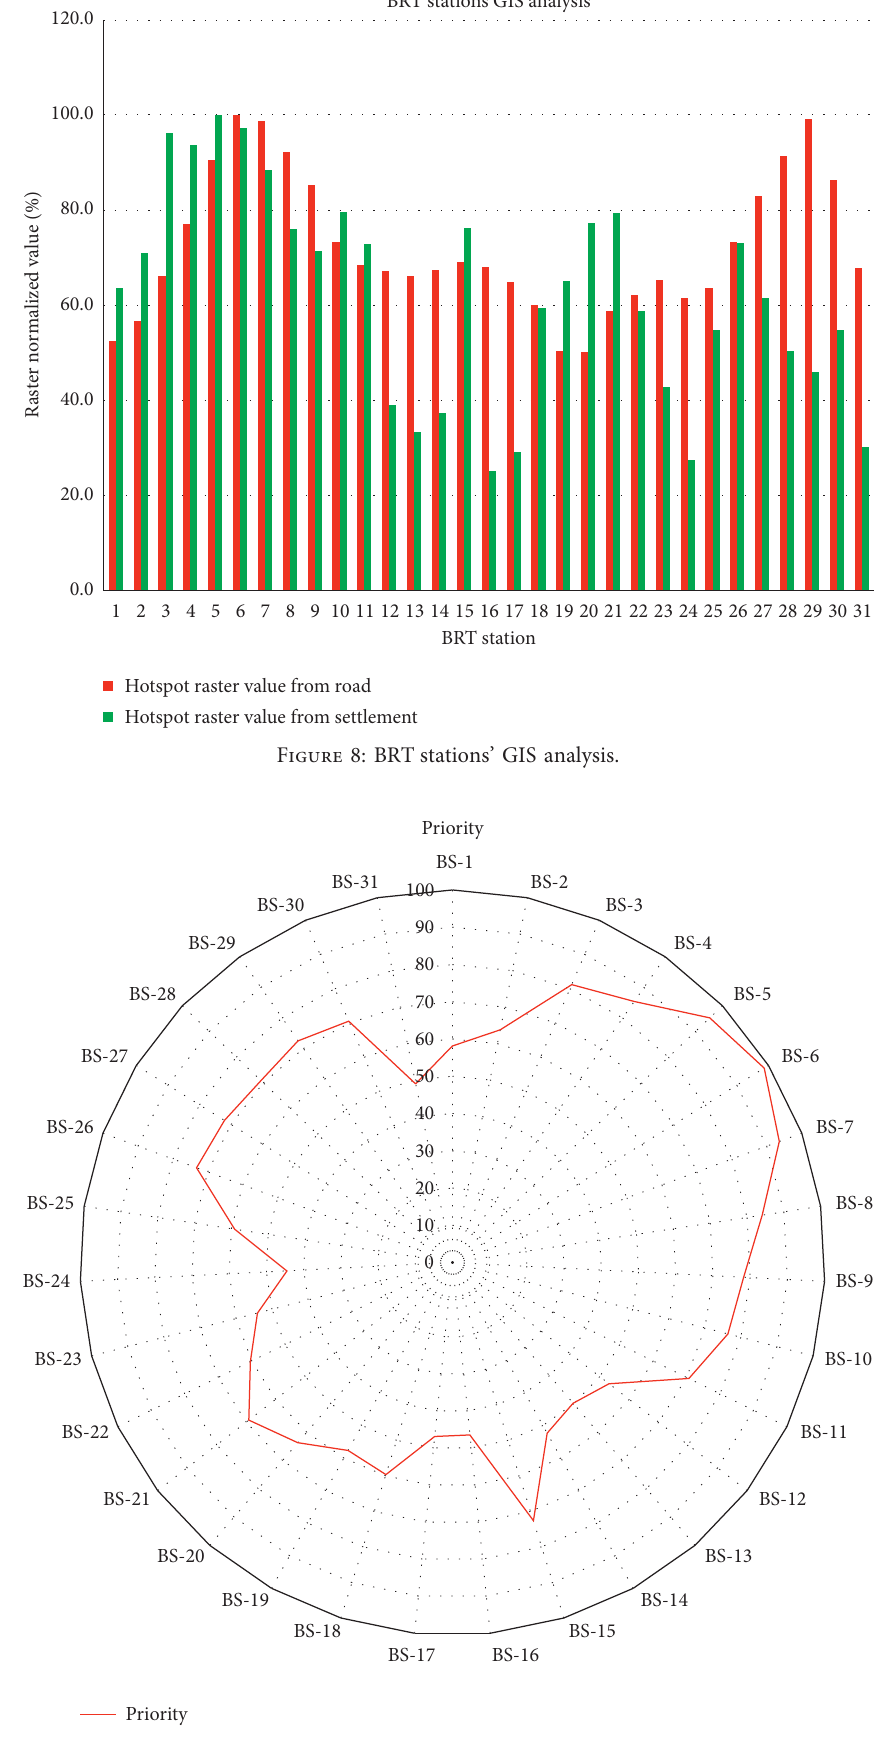
Figure 9: The BRT station priority graph.